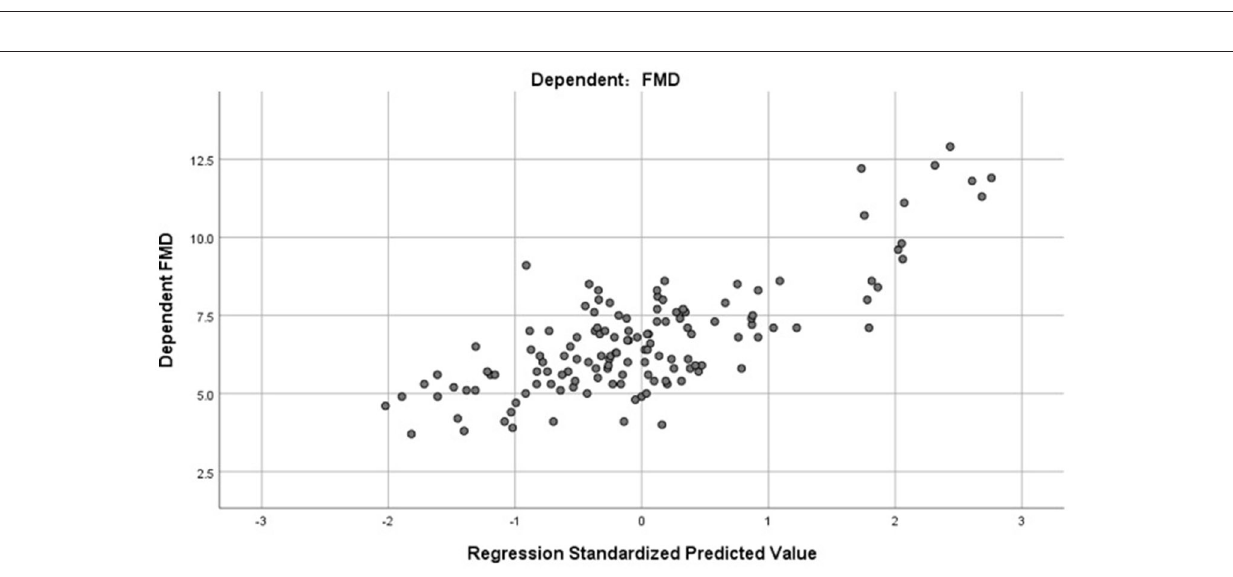
FIGURE 3 | The residual scatter plot of standardized predicted value and standardized residual.